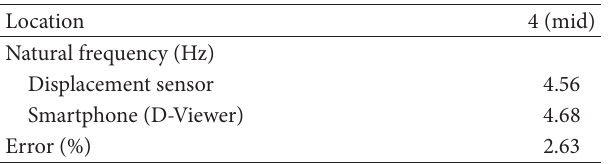
Table 8: Comparison of natural frequency identified from displace- ment